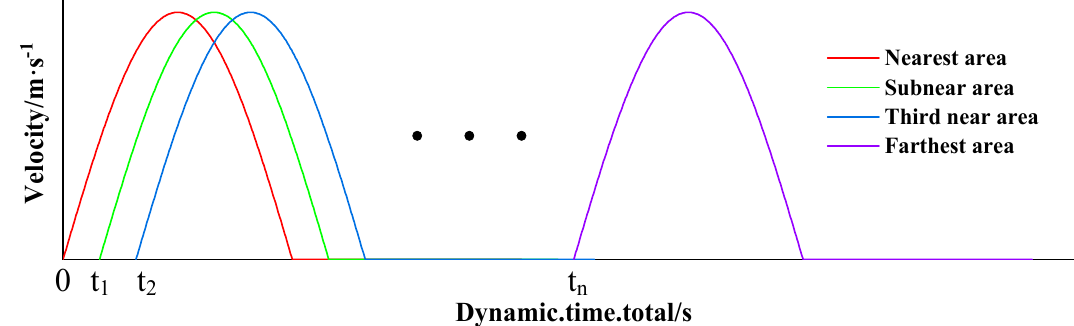
Figure 3 is the schematic diagram of arrival time of dynamic load at the top surface grid of the model. This paper applied dynamic load as described above in order to guarantee Figure 2. Schematic diagram of dynamic load application to model top grid. that the simulation results would be closer to reality.